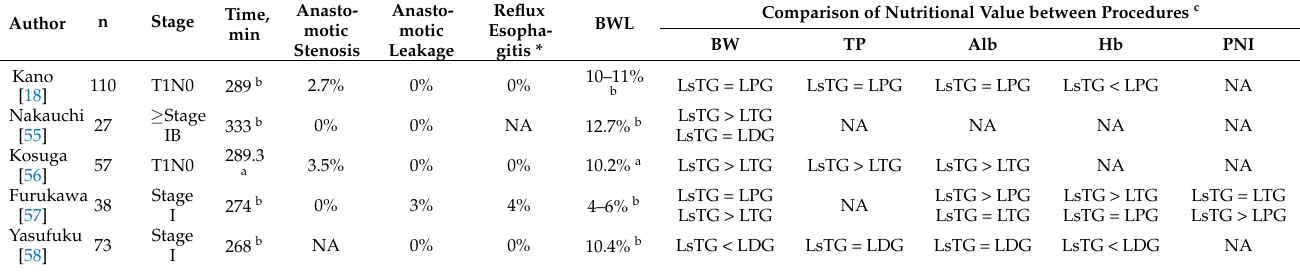
Table 4. Summary of LsTG